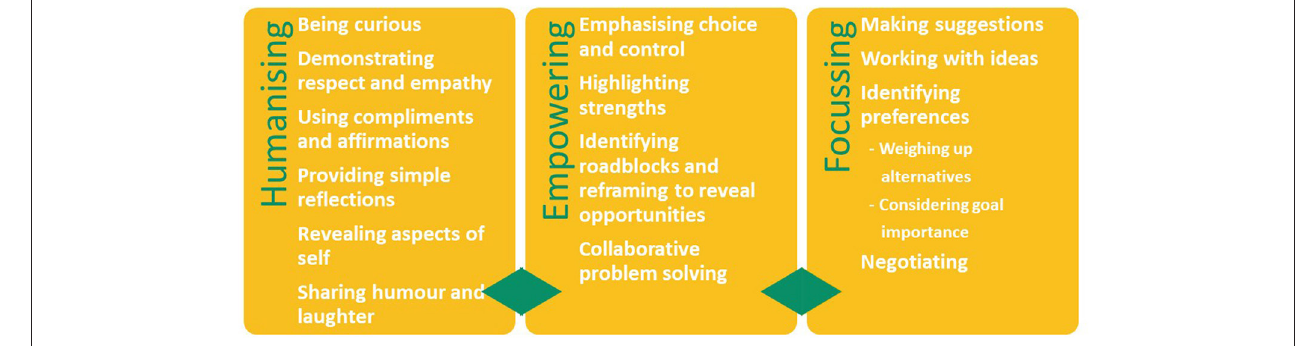
FIGURE 1 | Clinical strategies and subthemes.